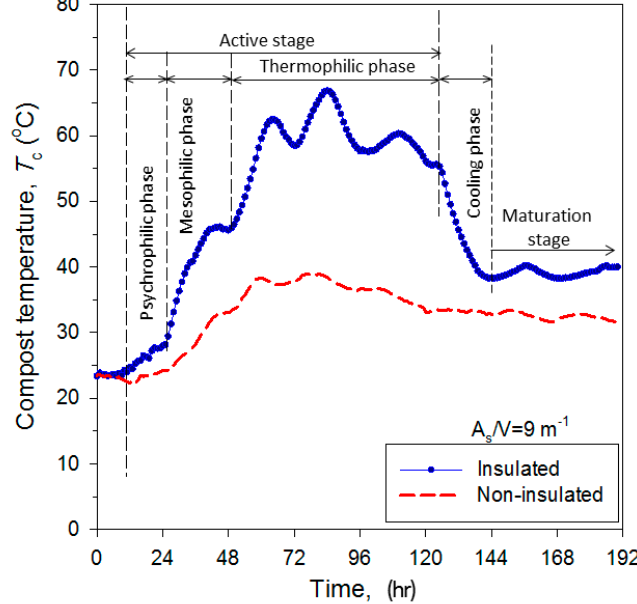
Figure 6. Outline of main phases of composting process based on measured compost temperatures ( T c ) in insulated and non-insulated bioreactors.